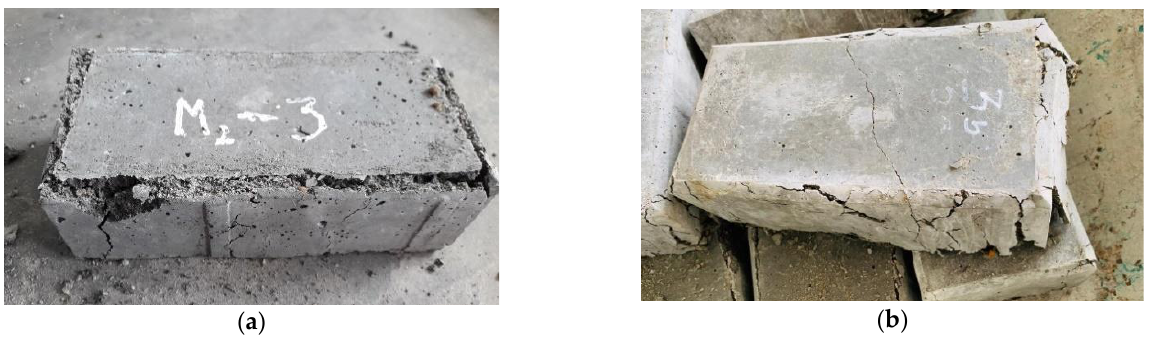
Figure 7. Failure Patterns of the IPB from Batch 1 and 2: ( a ) CR-based block; ( b ) CCF-based block.